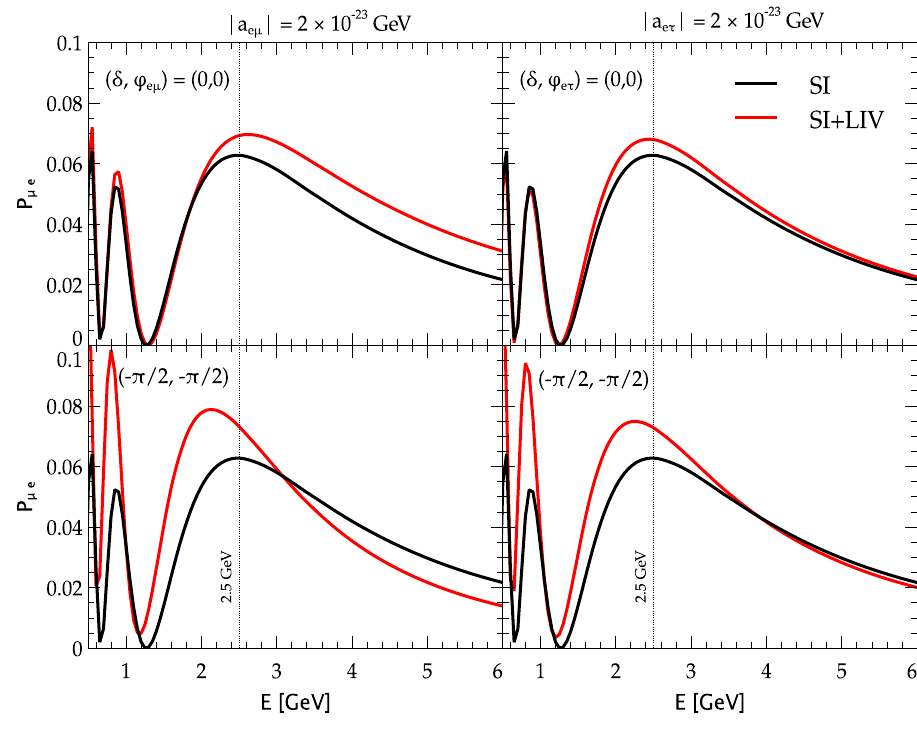
Fig. 1 ν μ → ν e transition probability as a function of neutrino energy. In each panel, black curve shows the probability considering only the standard interaction (SI). The red curves depict how the LIV parameters a e μ (left panels) and a e τ (right panels) affect P μ e . The strength of the LIV parameters is assumed to be | a e μ | = | a e τ | = 2 × 10 − 23 GeV (taken one at-a-time). In top (bottom) panels, we assume CP-conserving (CP-violating) values of the two relevant phases δ and ϕ e β , whose values are mentioned in each panel. Here, we assume NO and for the three-flavor oscillation parameters, we take the values θ = 34 . 5 ◦ ,θ = 8 . 45 ◦ ,θ = 12 13 23 = 7 . 5 × 10 − 5 eV 2 , 47 . 7 ◦ ,(cid:8) m 2 21 = 2 . 5 × 10 − 3 eV and (cid:8) m 2 31